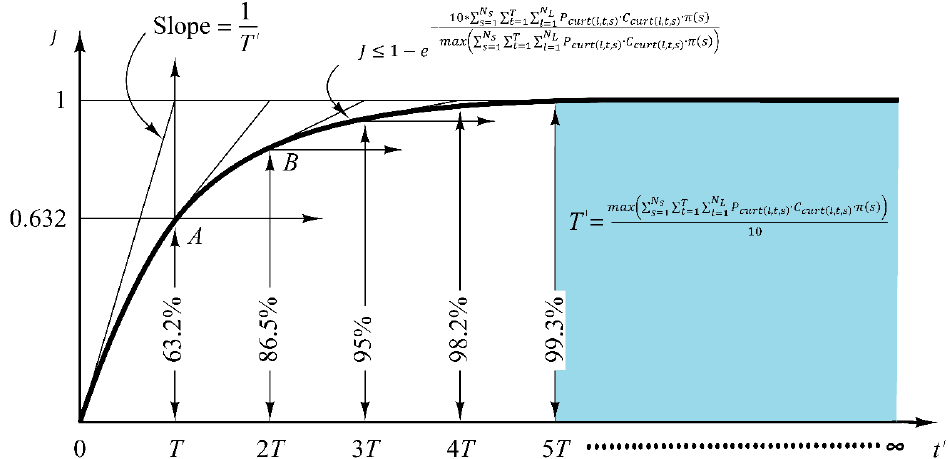
Figure 8. Exponential response curve for the first order system [40].